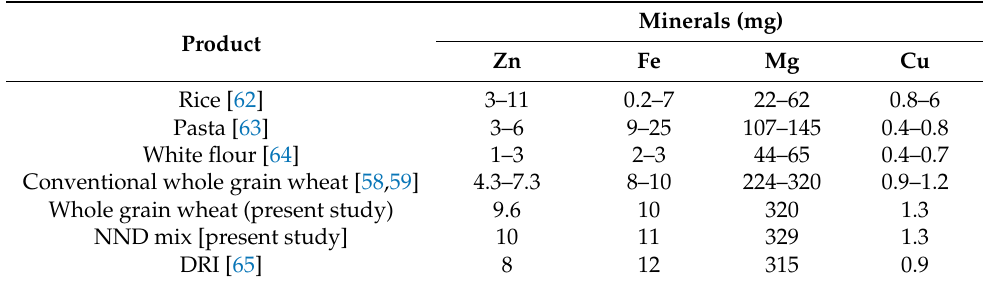
Table 8. Contribution to four of the most essential minerals in the human diet by 250 g of the product and a comparison with the daily recommended intake